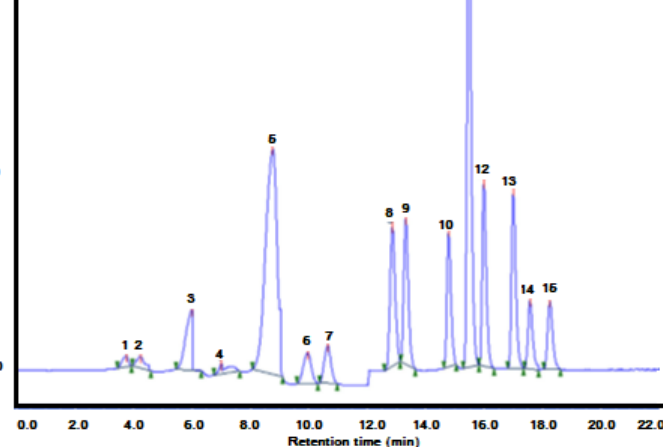
Figure 15. On ‐ line DLLME–HPLC chromatogram of water spiked with 0.02 μ g L − 1 of each PAH. PAHs were preconcentrated from 4 mL of sample. The elution order and retention times are shown in Table 3. (1) Naphthalene (Nap), (2) acenaphthene (Acp), (3) fluorene (Flu), (4) phenanthrene (PA),